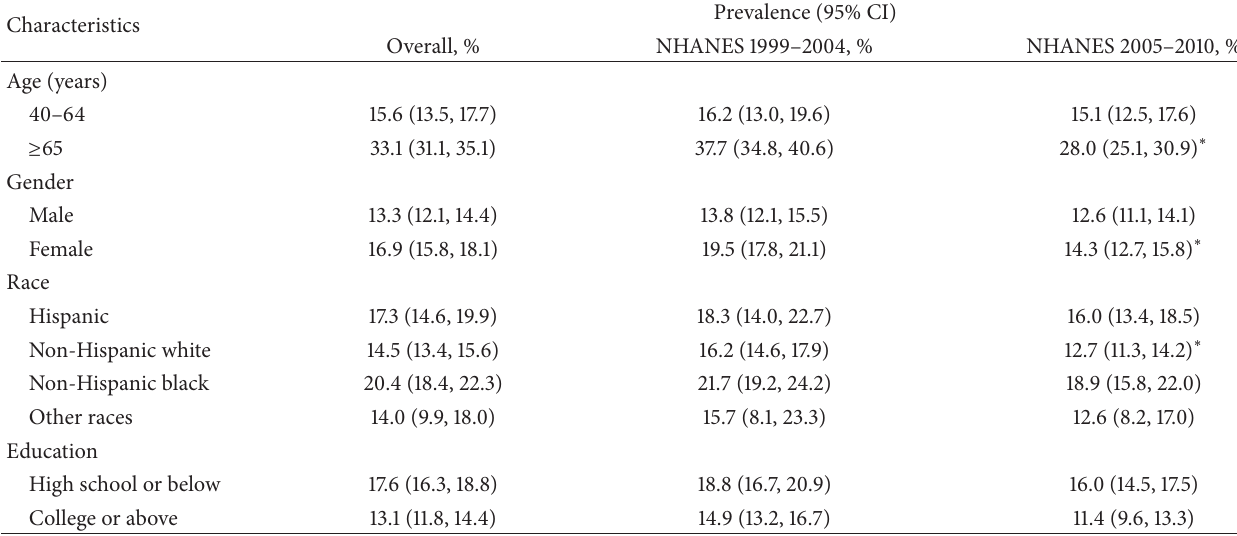
Table 2: Prevalence and changes of untreated isolated systolic hypertension by age, gender, race, and education in NHANES 1999–2010, USA.